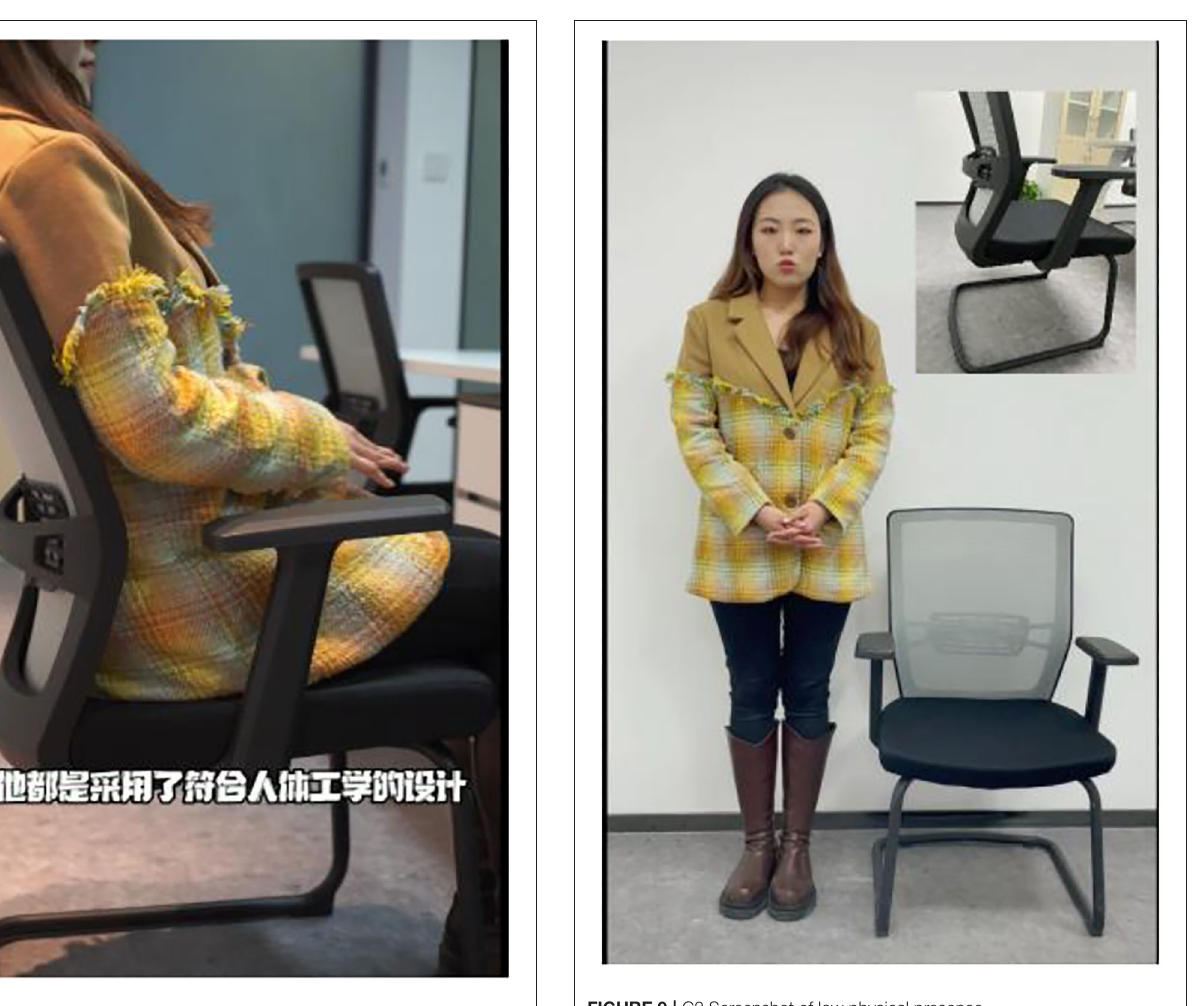
FIGURE 8 | C1 Screenshot of high physical presence.